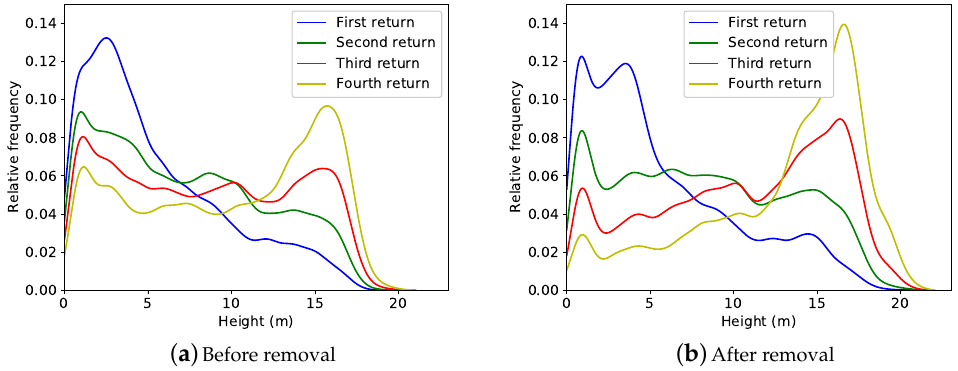
Figure 6. Comparison of the frequency distribution with Gaussian kernel density estimation of different vertical returns with height between the pre-cut ( a ) and post-cut ( b ) data of the removal